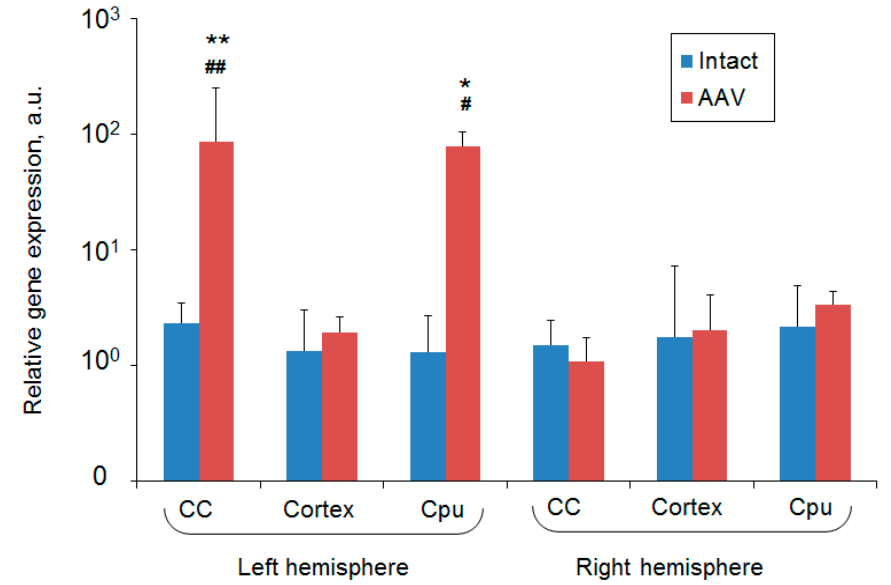
Figure 9. RT-PCR detection of ferritin mRNA expression in the di ff erent regions of the rat brain extracted from the intact (blue bars, n = 4) or AAV-pDCX-FerrH-injected animals (red bar, n = 4). Data are presented as mean ± SE. Statistically-significant di ff erences in relative gene expression according to ANOVA after LSD’s correction for multiple comparisons: in comparison with probes of intact animals, * p < 0.05 and ** p < 0.01; in comparison with the right hemisphere, # p < 0.05 and ## p < 0.01. Abbreviations: CC, corpus callosum; CPu, caudoputamen; AAV, adeno-associated viral backbone.